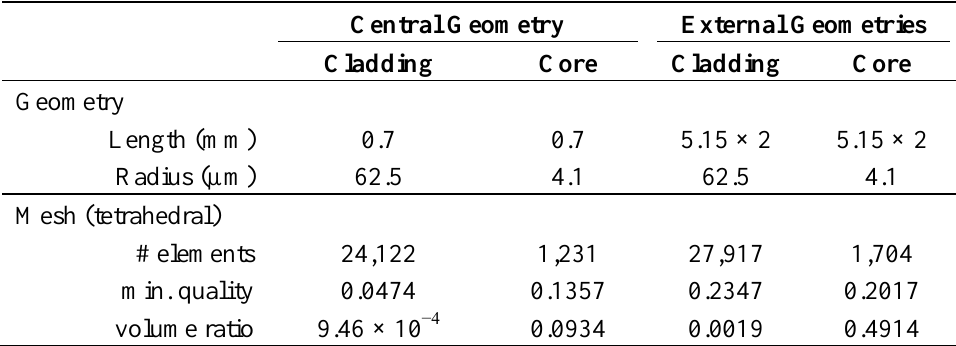
Table 1. Geometry data and mesh